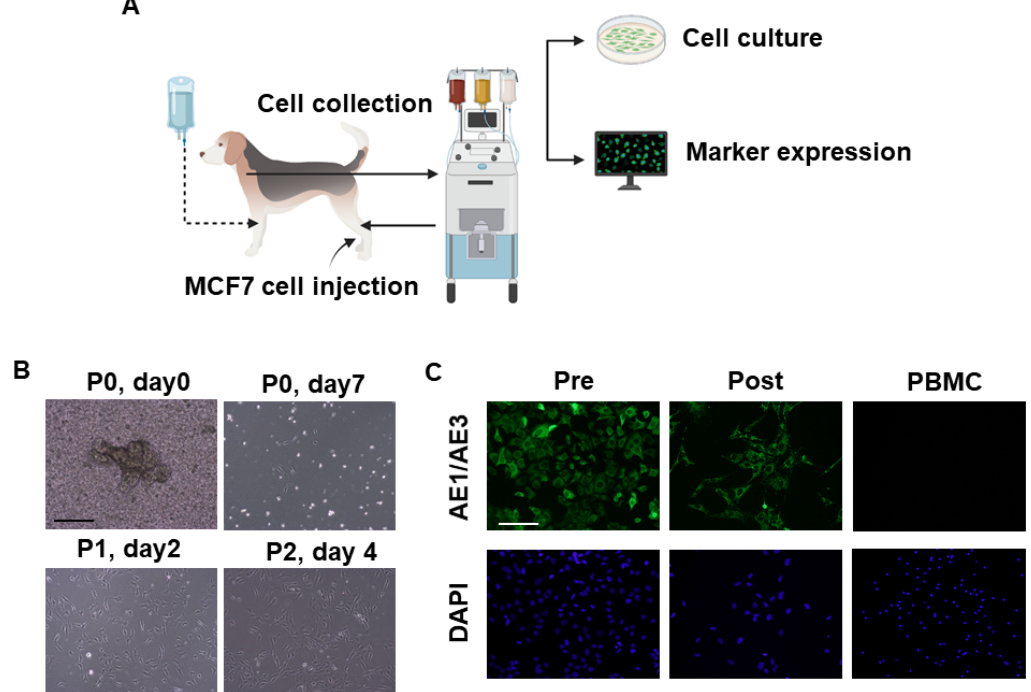
Figure 5. Cancer cell collection by apheresis in dogs. Schematic illustration of MCF7 injection, collection, culture, and characterization ( A ). Representative phase-contrast images of MCF7 cells after collection by apheresis (n = 2). Scale bar: 100 µm ( B ). Representative fluorescence images of epithelial cell marker, AE1/AE3 expression in MCF7 cells pre- and post-apheresis as well as in dog PBMC cells. Scale bar: 100 µm ( C ).